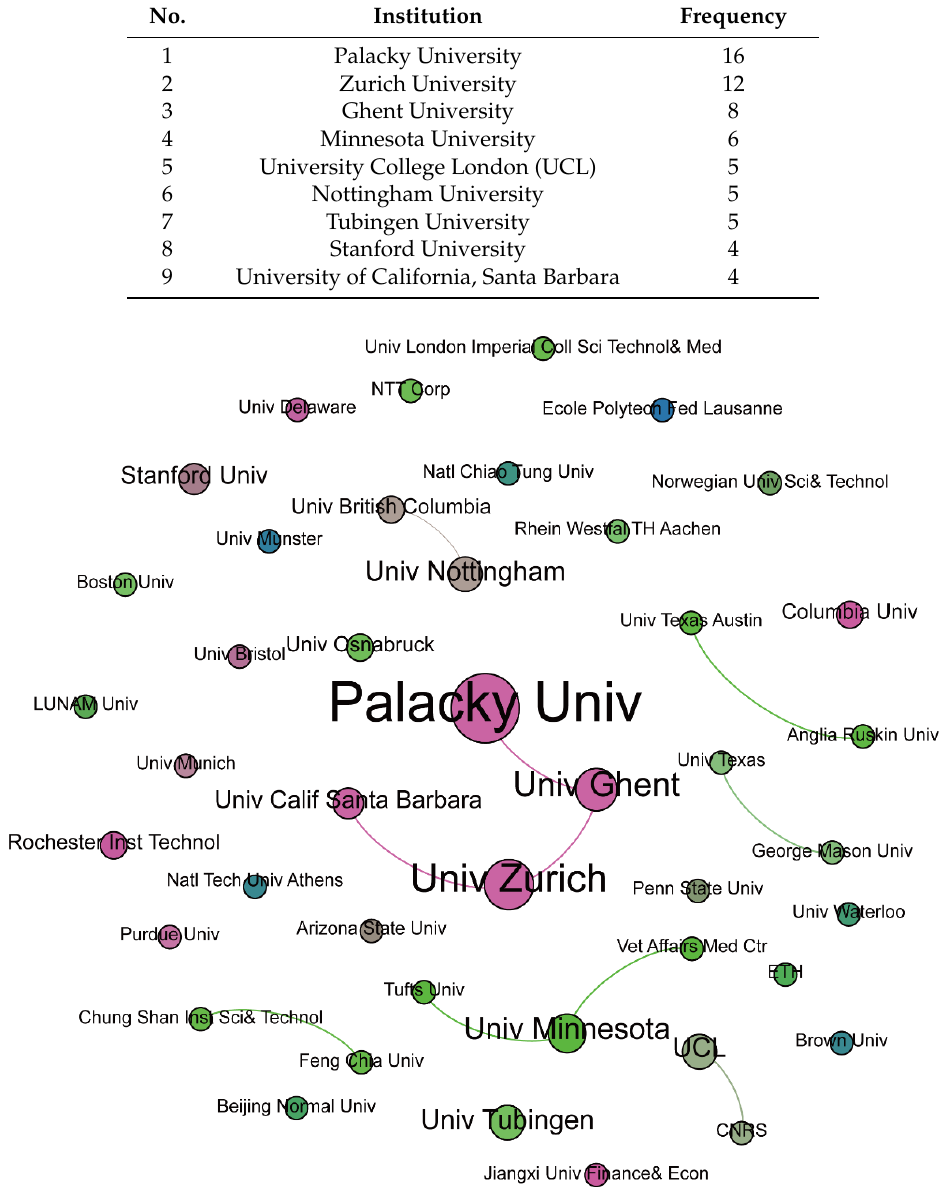
Figure 7. Co-occurrence network of institutions (size of the node represents institution’s publication Figure quantity).